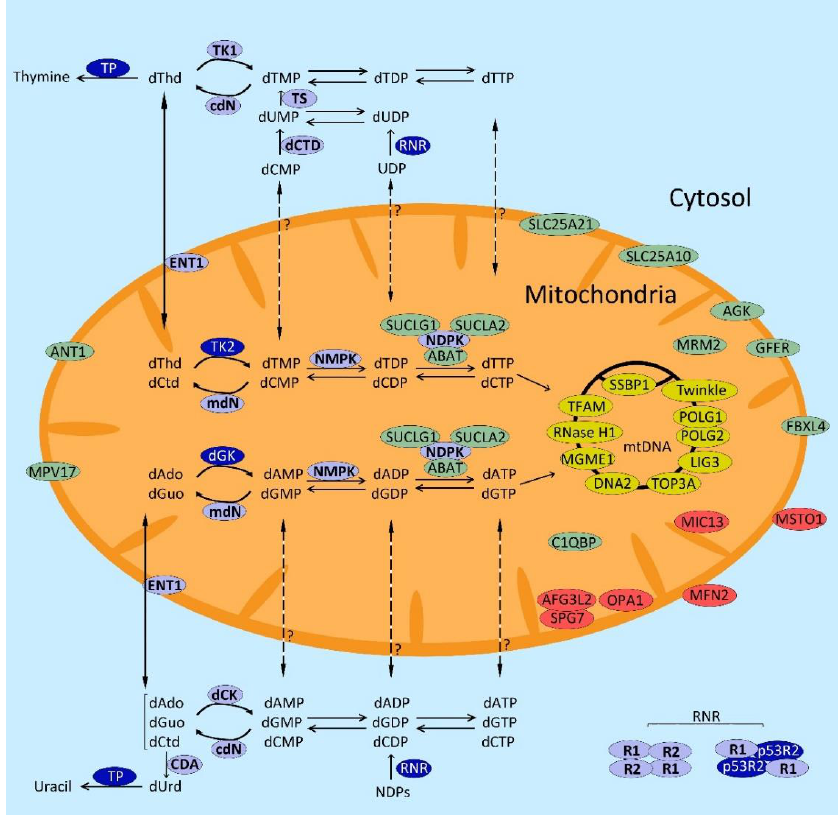
Figure 1. Metabolic pathways and proteins involved in mitochondrial DNA replication disorders. Proteins whose muta- tions have been linked to MDDS are depicted in yellow (mtDNA replication/maintenance machinery), dark blue (dNTP metabolism), red (mitochondrial dynamics) and green (unknown role in mtDNA replication). Light blue colour repre- sents proteins participating in dNTP metabolism but not associated with MDDS. Abbreviations: ABAT, 4-aminobutyrate aminotransferase; AFG3L2, AFG3-like protein 2; AGK, acylglycerol kinase; ANT1, adenine nucleotide translocator 1; CDA, cytidine deaminase; cdN, cytosolic deoxyribonucleotidase; C1QBP, complement component 1 Q subcomponent-binding protein; dAdo, deoxyadenosine; dCK, deoxycytidine kinase; dCtd, deoxycytidine; dCTD, deoxycytidylate deaminase; dGK, deoxyguanosine kinase; dGuo, deoxyguanosine; DNA2, helicase/nuclease DNA2; dThd, thymidine; dUrd, deoxyuridine; ENT1, equilibrative nucleoside transporter 1; FBXL4, F-box/LRR-repeat protein 4; GFER, growth factor, augmenter of liver regeneration; LIG3, ligase III; mdN, mitochondrial deoxyribonucleotidase; MFN2, mitofusin 2; MGME1, mitochon- drial genome maintenance exonuclease 1; MICOS13, MICOS complex subunit MIC13; MPV17, protein MPV17; MRM2, rRNA methyltransferase 2; MSTO1, protein misato homolog 1; NDPK, nucleoside diphosphate kinase; NMPK, nucleoside monophosphate kinase; OPA1, dynamin-like 120 kDa protein; POLG1, catalytic subunit of polymerase gamma; POLG2, an- cillary subunit of polymerase gamma; p53R2; p53-inducible small subunit of the ribonucleotide reductase; R2, small subunit of the ribonucleotide reductase; RNASEH1, ribonuclease H1; RNR, ribonucleotide reductase; SLC25A10, mitochondrial dicarboxylate carrier; SLC25A21, mitochondrial 2-oxodicarboxylate carrier; SPG7, paraplegin; SSBP1, mitochondrial single strand binding protein; SUCLA2, β -subunit of the succinate-CoA ligase; SUCLG1, α -subunit of the succinate-CoA ligase; TFAM, mitochondrial transcription factor 1; TK1, thymidine kinase 1; TK2, thymidine kinase 2; TOP3A, DNA topoisomerase 3 alpha; TP, thymidine phosphorylase; TS, thymidylate synthase; Twinkle, mitochondrial helicase. Right bottom corner: the 2 isoforms of tetrameric RNR are represented, 2R1/2R2 (active in proliferating cells) and 2R1/2p53R2 (active throughout the cell cycle). Question marks indicate that the mitochondrial transporter(s) of the deoxyribonucleoside mono-, di- and triphosphates has or have not been identified. Figure generated using the Adobe ® Photoshop ® CS5